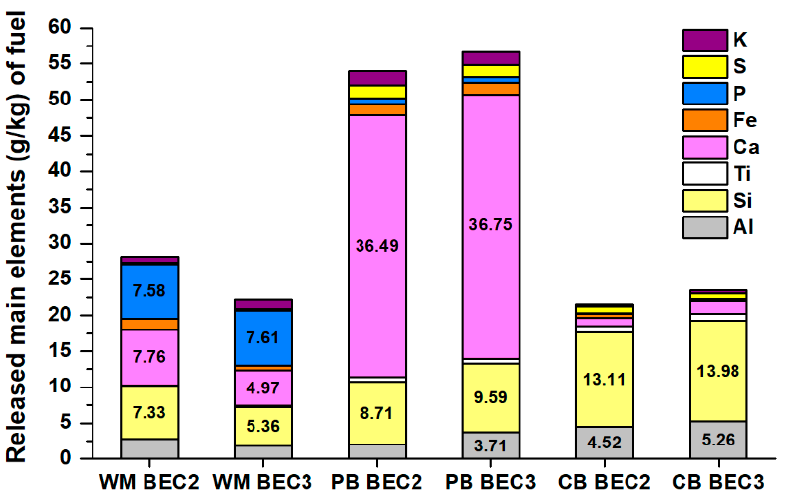
Figure 4. Major elements (Al, Si, Ti, Fe, Ca, S, K, and P) released from the burning of 1 kg of fuel in BEC2 and BEC3.